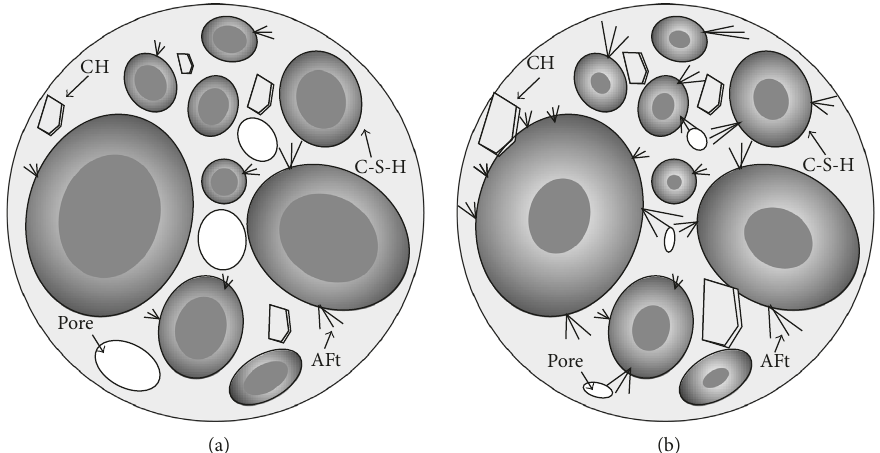
Figure 7: Schematic for the morphology model of hydrates in the DE material: (a) initial swelling stage; (b) secondary swelling